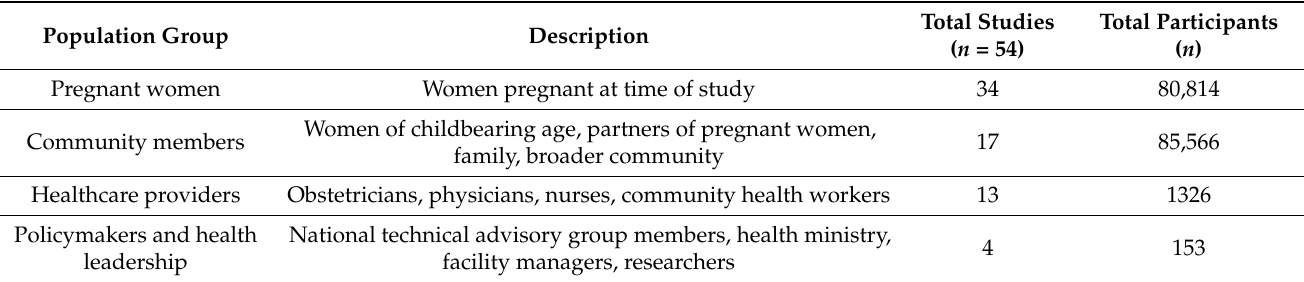
Table 1. Representation of participants involved in included studies on maternal vaccination in